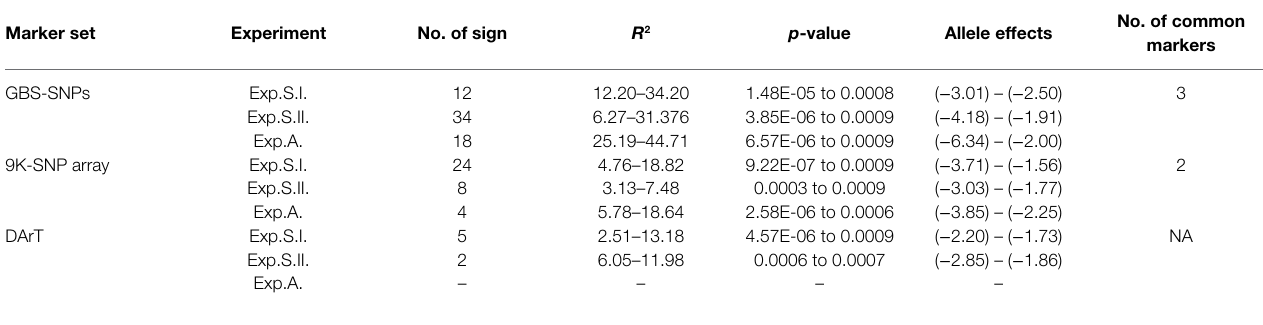
TABLE 3 | Summary of significant markers identified for each experiment based on genome-wide association study using GBS-SNPs, 9K-SNP array, and DArT markers. Marker set